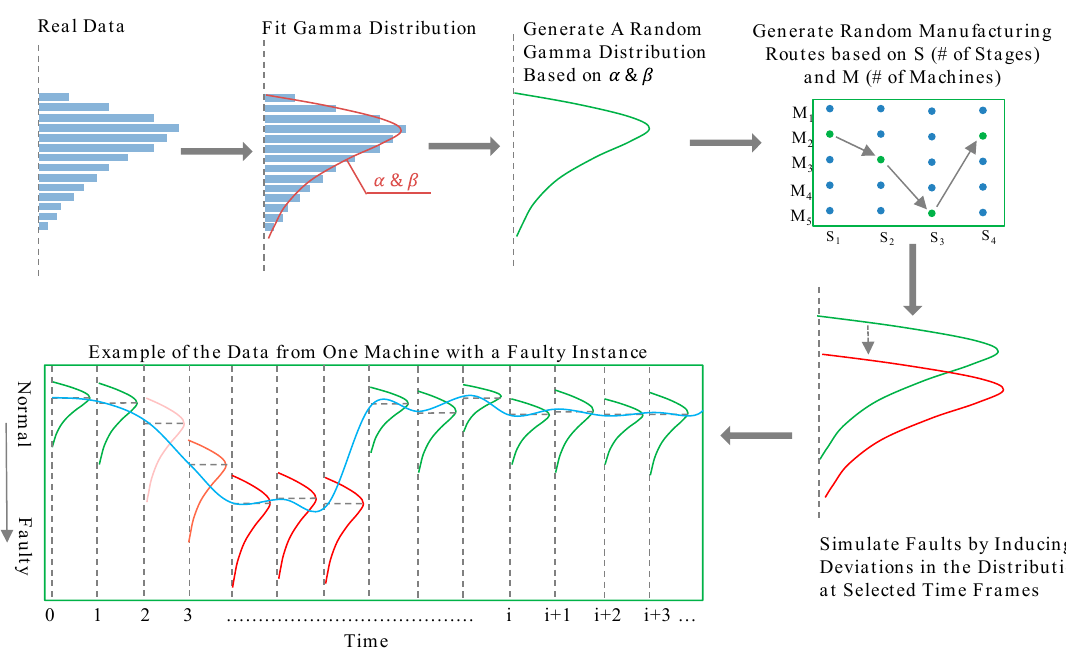
Figure 5. The process of using the Monte-Carlo simulation for generating data from a manufacturing process with arbitrary number of stages and machines.